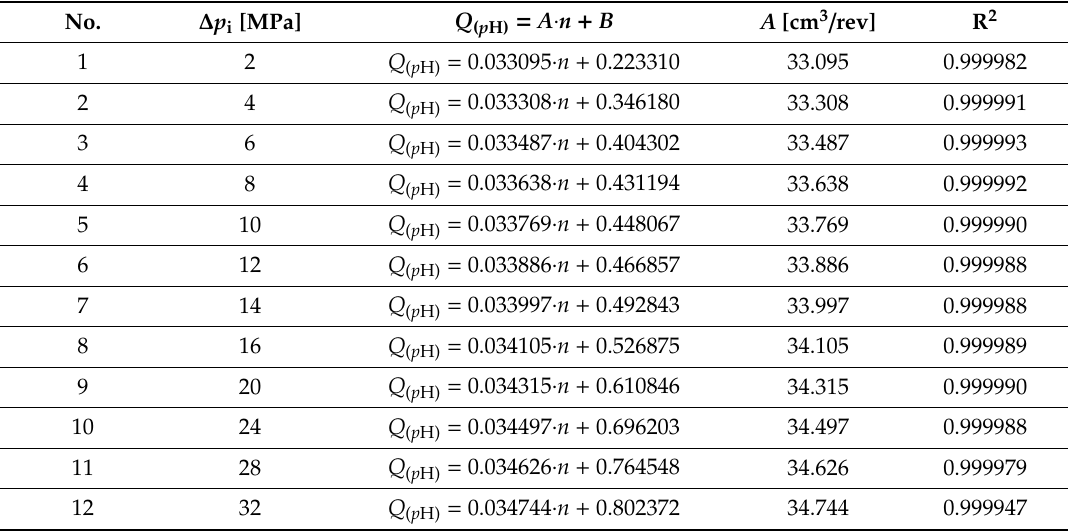
Table A6. Equations Q ( p H) = A · n + B of motor output flow rate at ∆ p i = const. (new